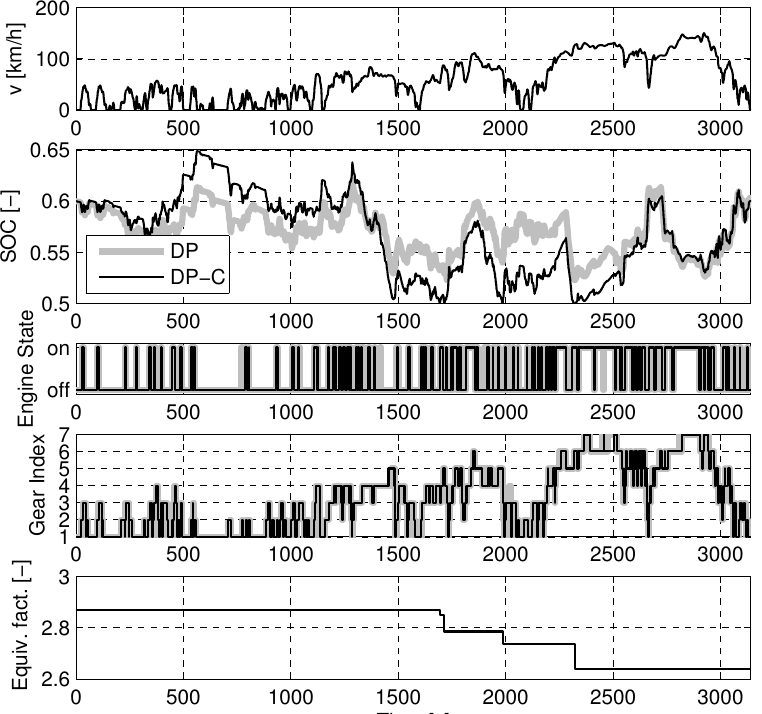
Figure 10. Comparison of the results obtained with DP and the DP-C algorithm on the CADC driving cycle with limited SOC